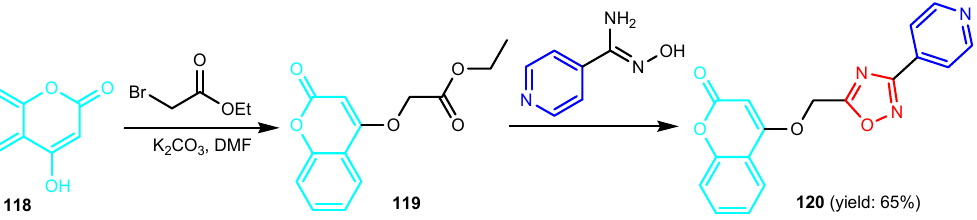
Scheme 26. Synthesis of 4-[(3-(4-pyridyl)-1,2,4-oxadiazol-5-yl)methoxy]-coumarin 120 [55].